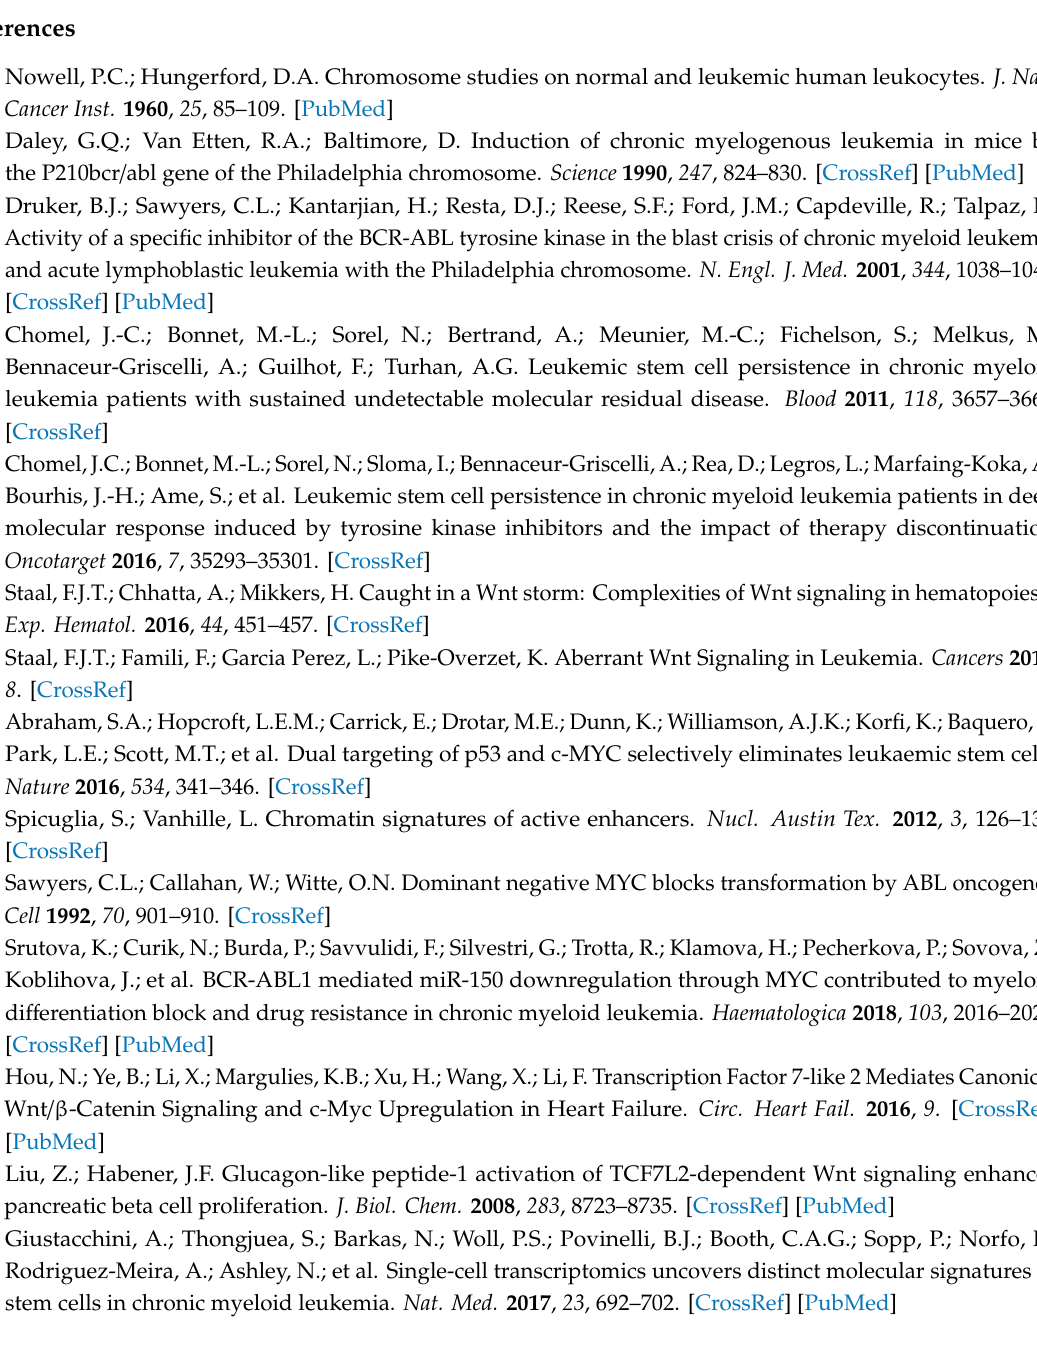
proximal binding; Supplementary Table S5: Table of the QRT-PCR primers used in functional test to validate the regulation of TCF7L2-MYC